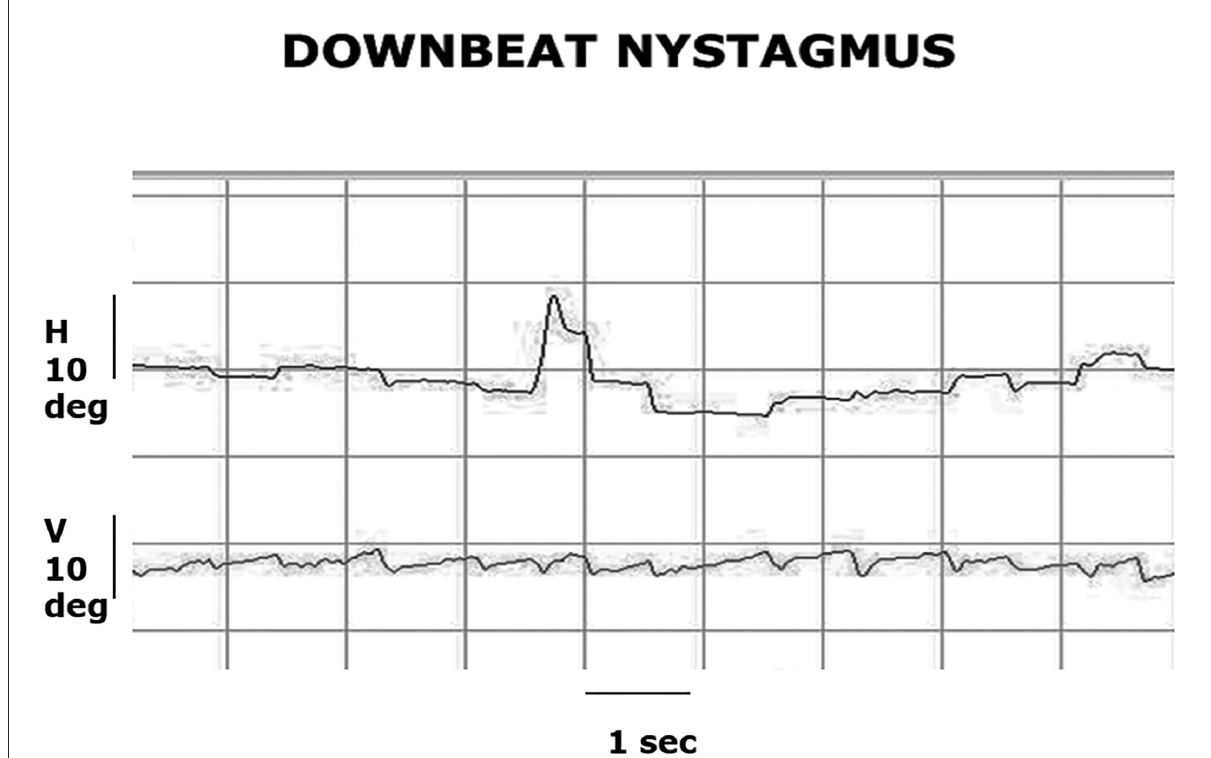
FIGURE1 Video-oculography (VOG) recording of central fixation. The patient has a primary gaze, low-amplitude downbeat nystagmus with a slow phase velocity of 2 deg/sec and a frequency of 2Hz, and this nystagmus increases in amplitude and velocity in right and left